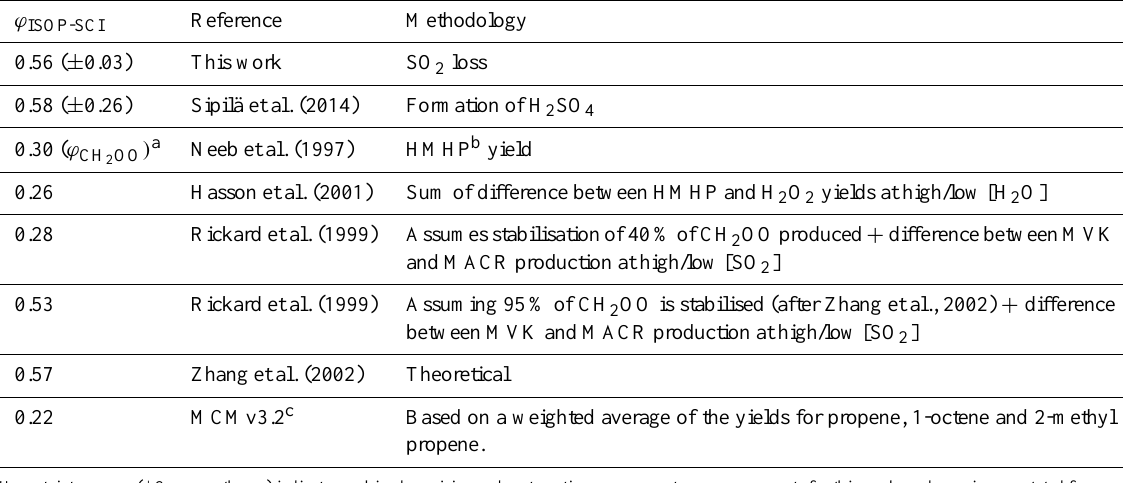
Table 1. Total isoprene SCI yields derived in this work and reported in the literature. ϕ ISOP-SCI Reference Methodology This work